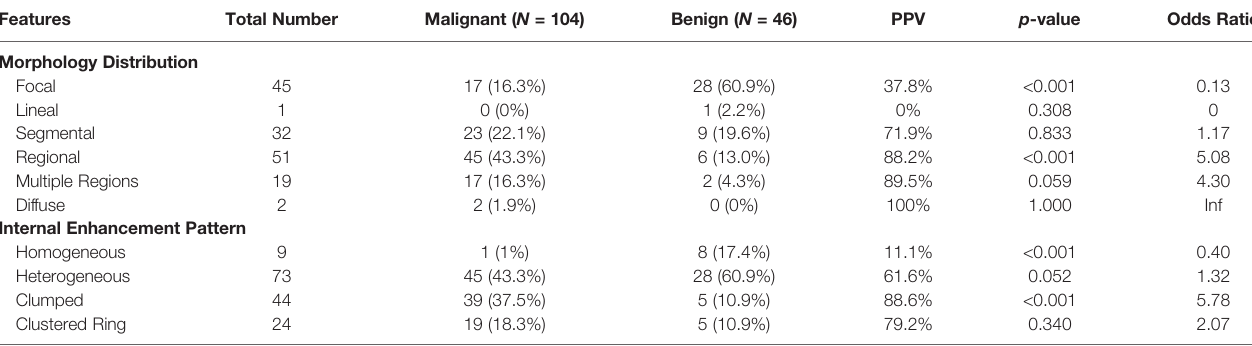
TABLE 2 | BI-RADS category for morphology distribution and internal enhancement pattern in malignant and benign groups.